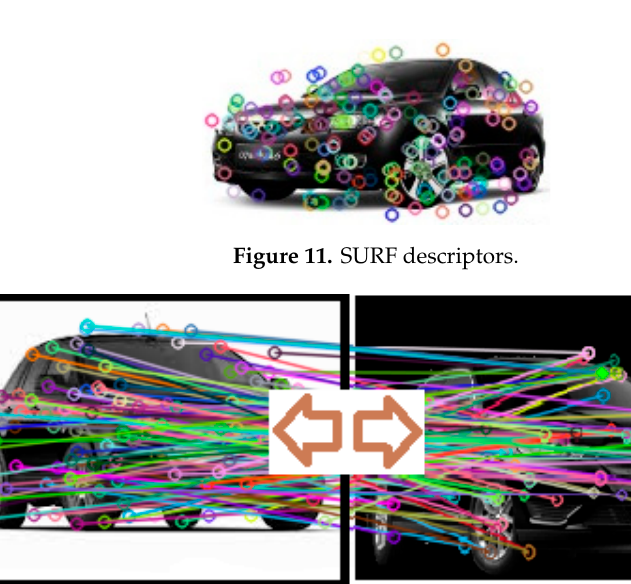
Figure 12. SURF matching descriptors.